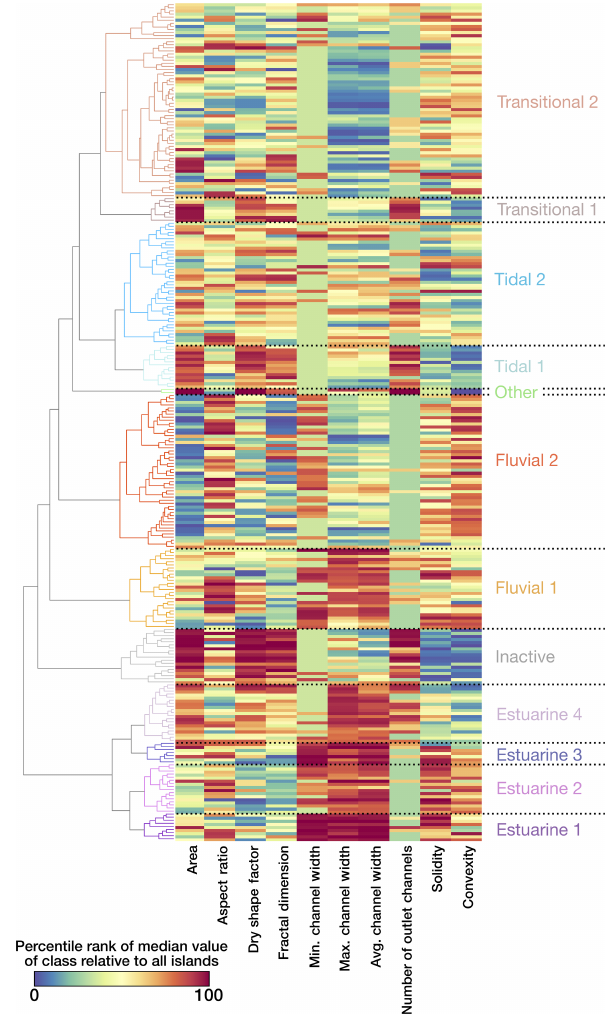
Figure 6. Dendrogram of classification and heatmap of variables. Warm colors indicate a high median value of a given parameter rel- ative to the delta-wide median, whereas cool values indicate a low cluster median relative to the delta-wide median